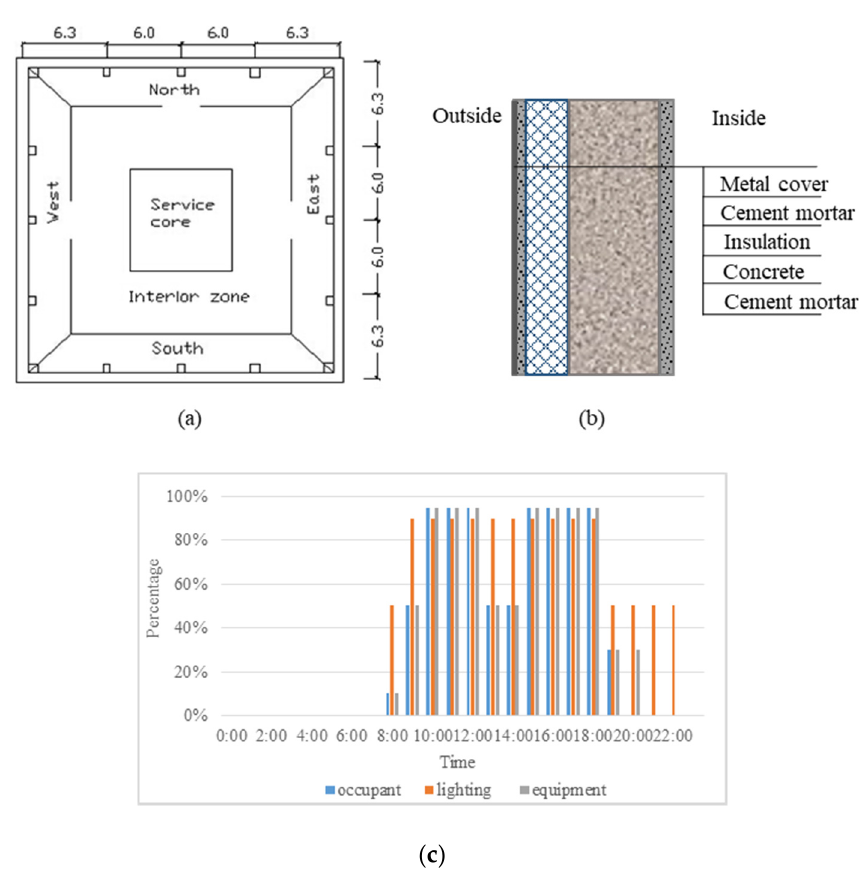
Figure 3. Building information. ( a ) The plan of a standard floor, ( b ) external wall construction